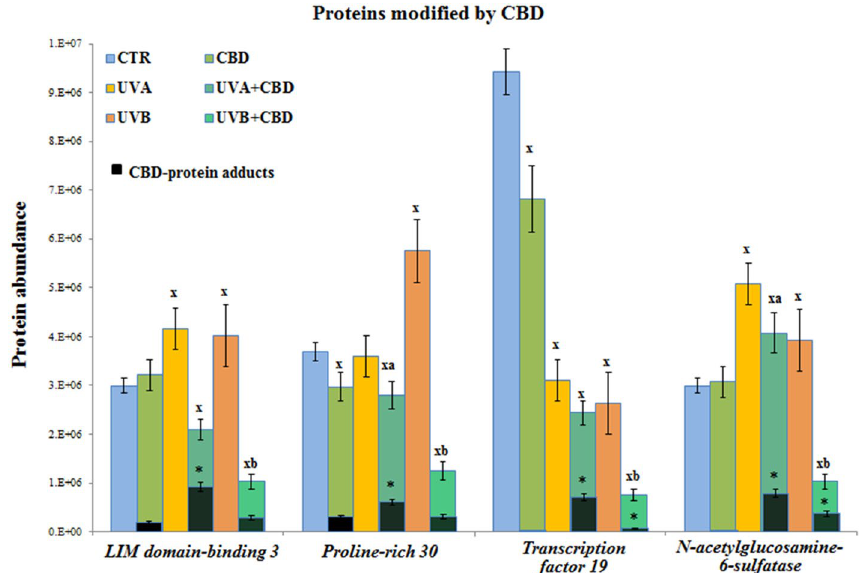
Figure 5. The level of proteins modified by cannabidiol (CBD) in plasma from the control rats (CTR) and animals topically treated with cannabidiol (2.5 g CBD in 100 g petrolatum) and/or irradiated with UVA (increasing doses from 0.5 to 5 J/cm 2 ) or UVB (increasing doses from 0.02 to 2 J/cm 2 ). Mean values ± SD of